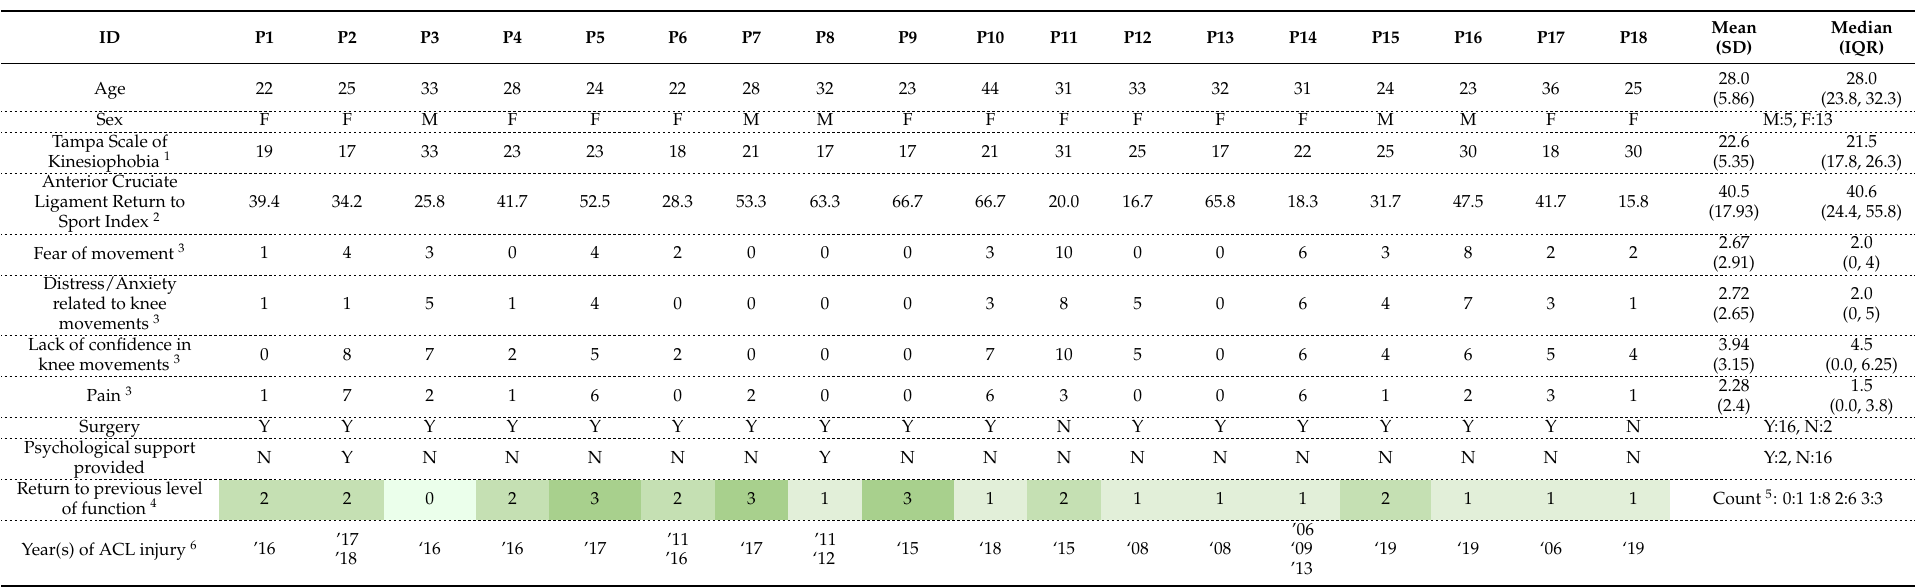
Table 1. Individual Participant